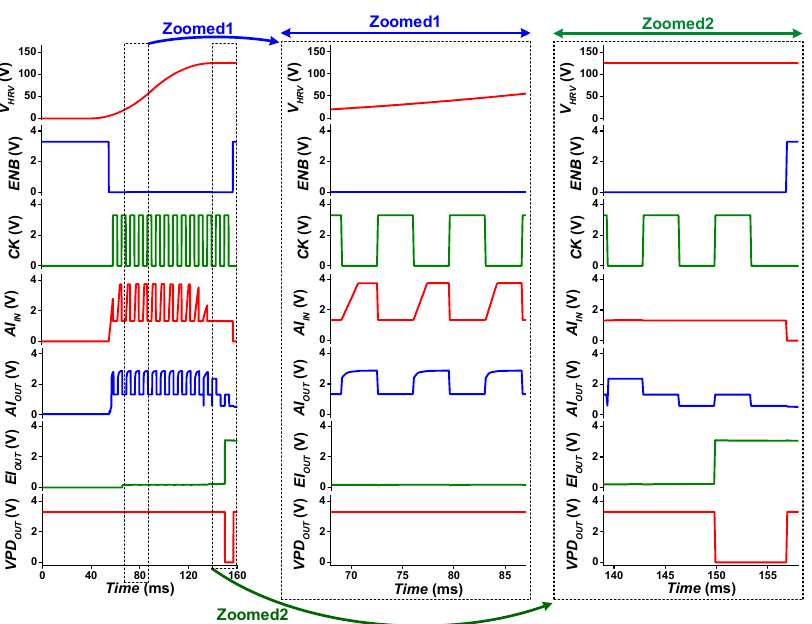
Figure 10. Voltage peak detector operation waveform.